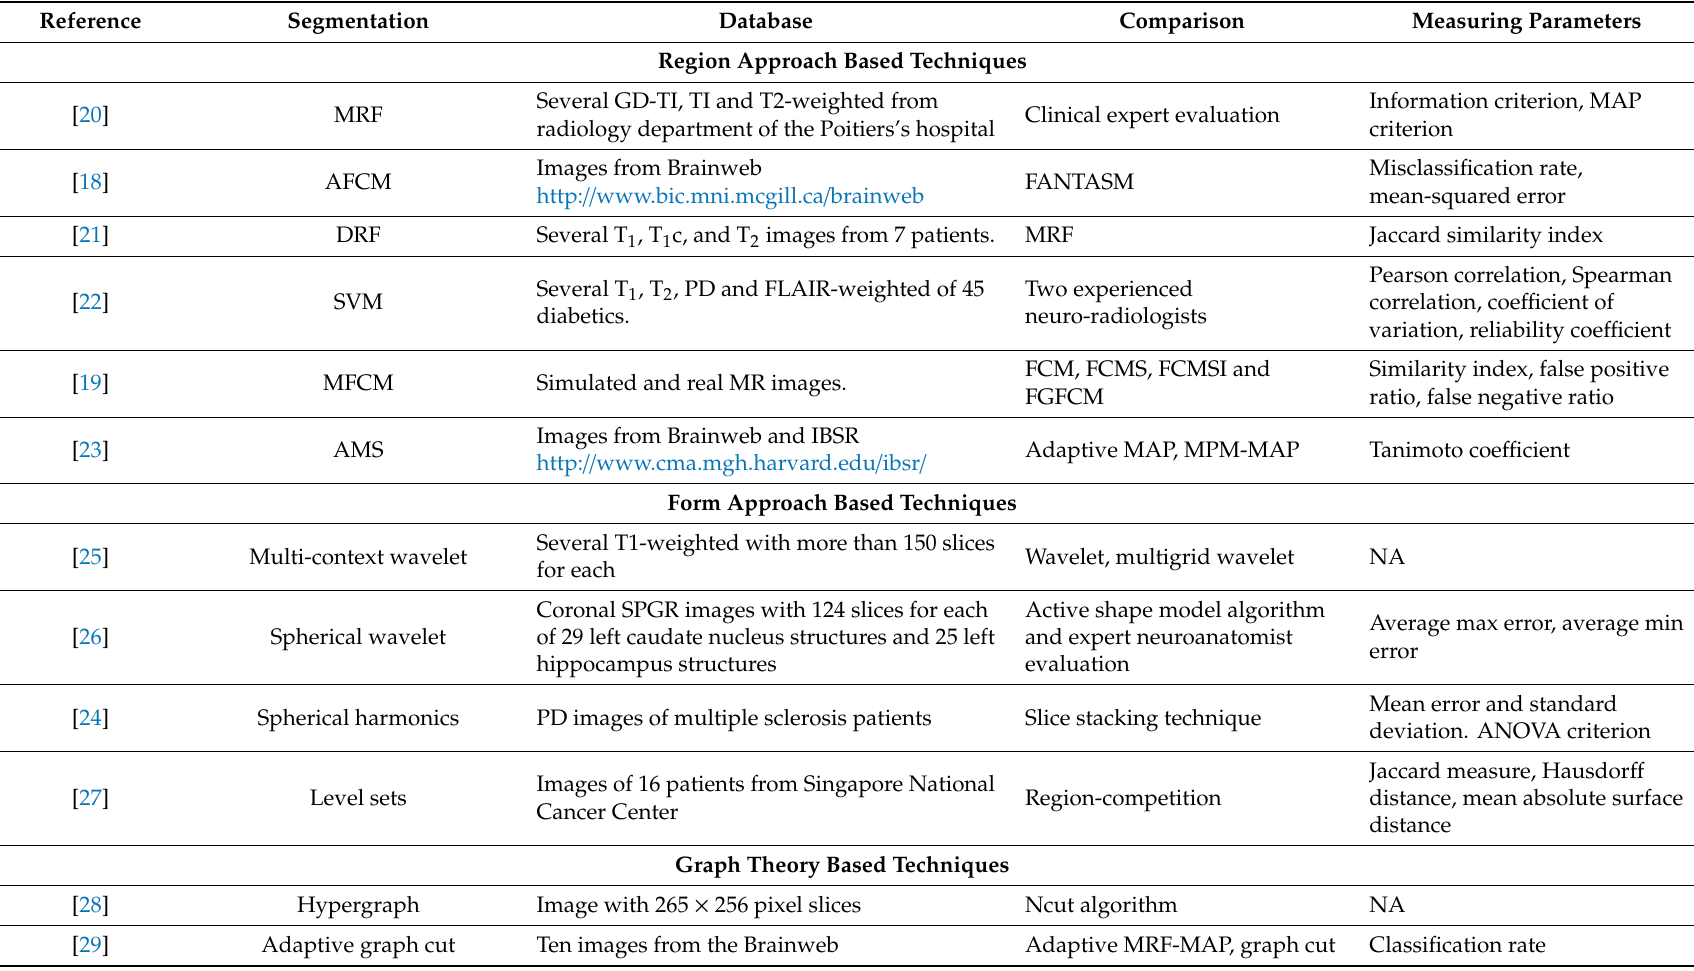
Table 1. Related work to the MRI brain regions segmentation using some techniques described in the literature: The e ffi ciency of the proposed automatic segmentation algorithm is demonstrated by experiments applying quantitative measurement parameters (last column of the table) for the evaluation, and by comparison with visual observation of a clinical expert (manual segmentation) or with other state-of-the-art algorithms (penultimate